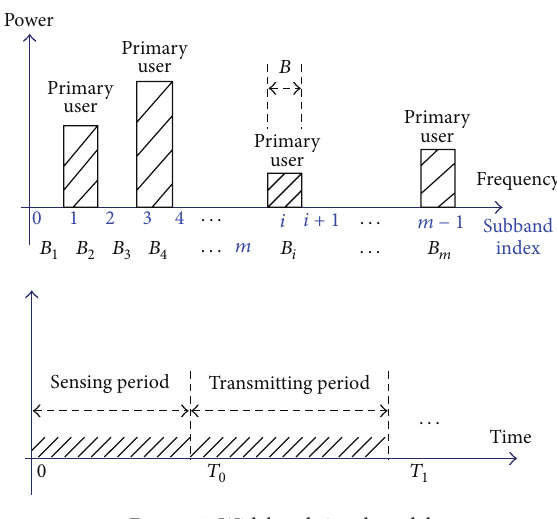
Figure 1: Wideband signal